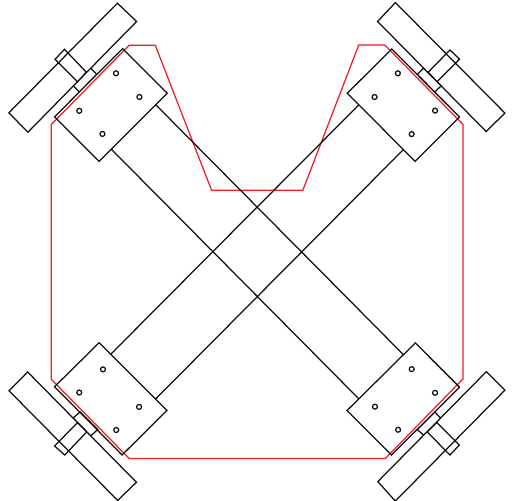
Figure 7: Omni-directional wheel